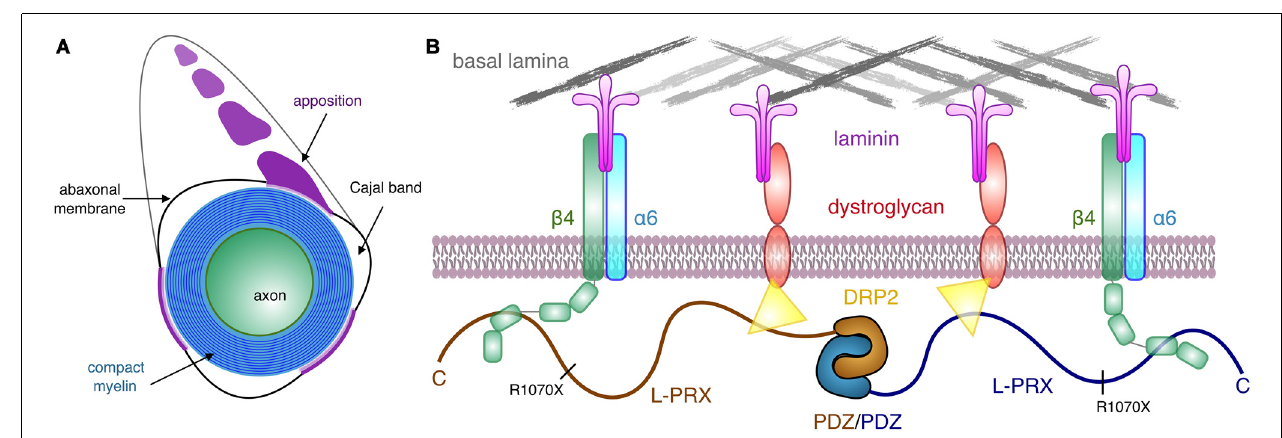
FIGURE 7 | Schematic view of the PRX-linked protein scaffold in peripheral nervous system (PNS) myelin. (A) Cross section of a myelinated peripheral axon, showing compact myelin, the abaxonal membrane, Cajal bands, and appositions. While dystrophin-related protein 2 (DRP2) is restricted to the appositions, and PRX is concentrated in them, β 4 integrin is involved in signaling in the Cajal bands (Salzer, 2015). (B) A possible architecture for L-PRX-based protein scaffolds at the Schwann cell abaxonal membrane. The position of the truncating R1070X mutation in L-PRX is indicated, and the β 4 integrin binding site lies C-terminal to it, although an exact binding site remains to be